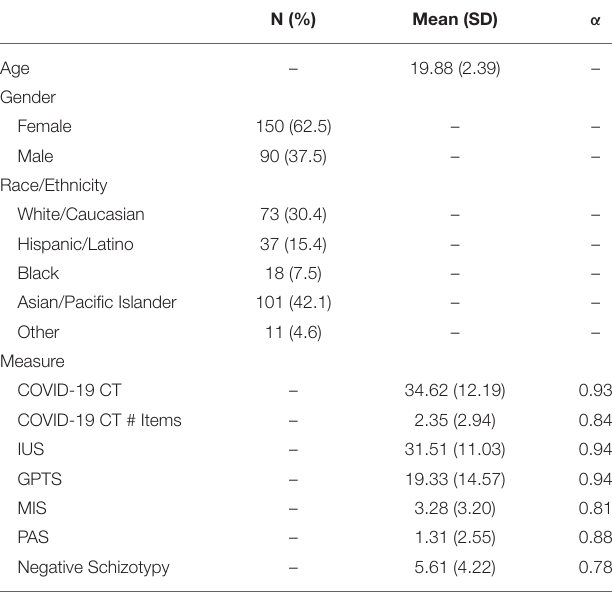
TABLE 1 | Demographics and questionnaire descriptives for Study